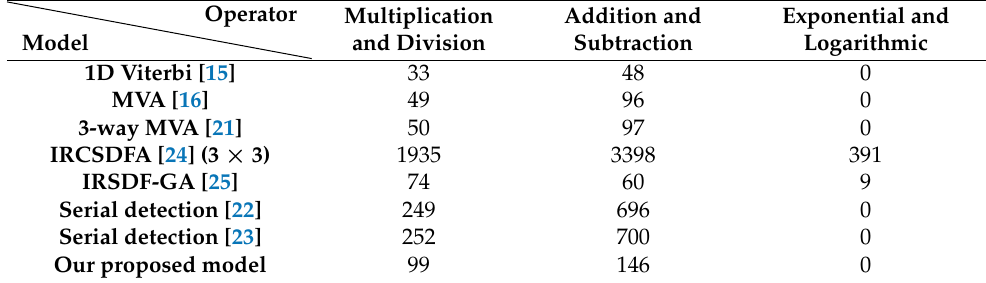
Table 4. Complexity of